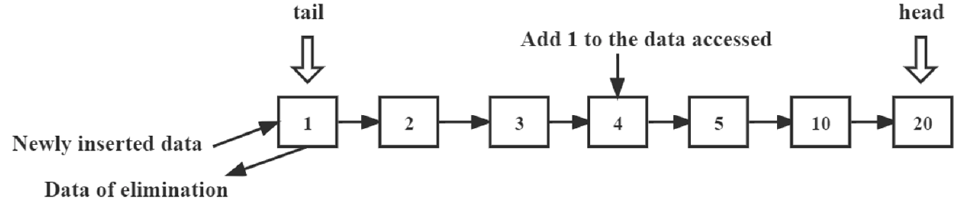
Figure 3. The idea of the LFU.